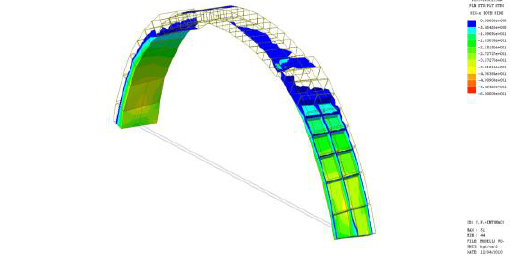
Figure 22b. Especially of arch after consolidation